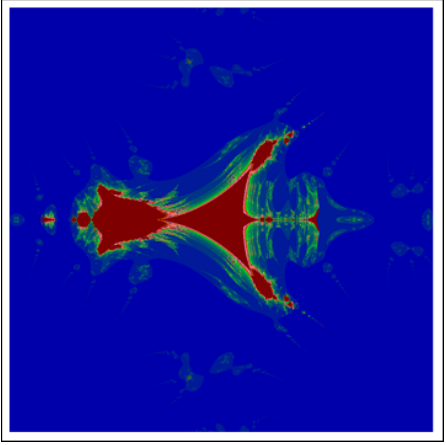
Figure 62. Tricorn via F-iteration with image visual time = 181.9